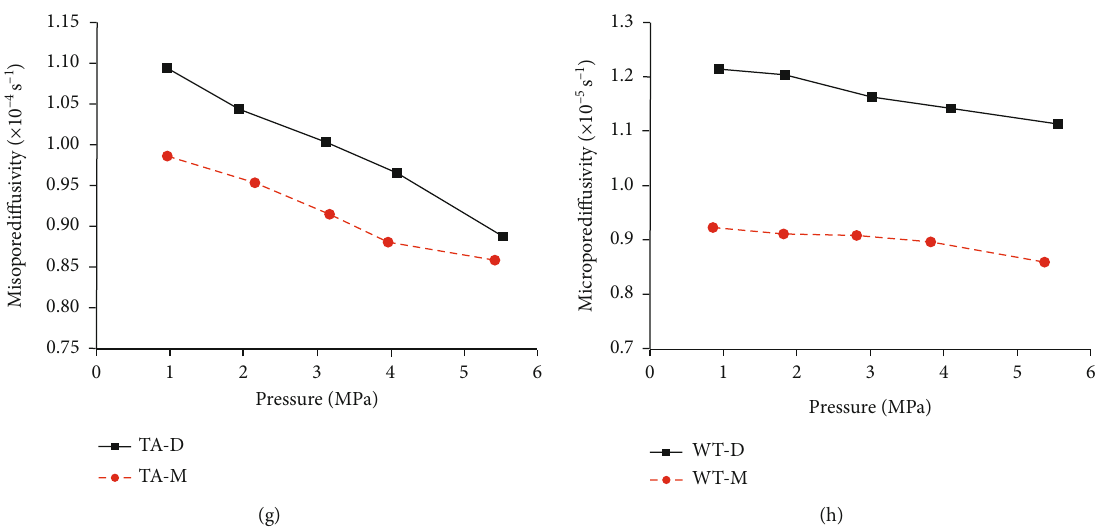
Figure 20: Relationships between gas di ff usion di ff usivities and pressure/moisture (modi fi ed from Li et al. [86] and Cui et al. [116]). Table 5: CH di ff usivity under di ff erent temperatures and pressures (data from Cai et al. [120]). 4 Gas species Temperature